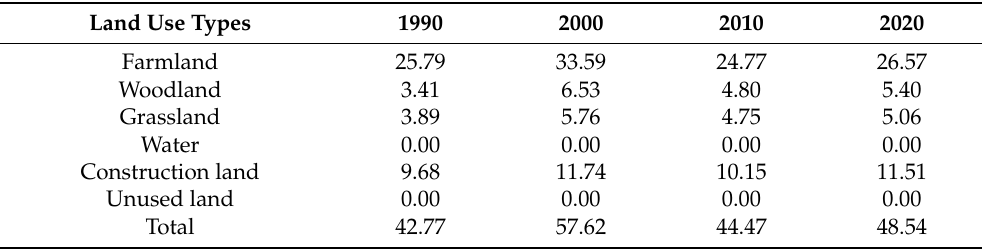
Table 3. Water yields of land use types for the Yellow River Basin (Henan section) from 1990 to 2020 (10 8 m 3